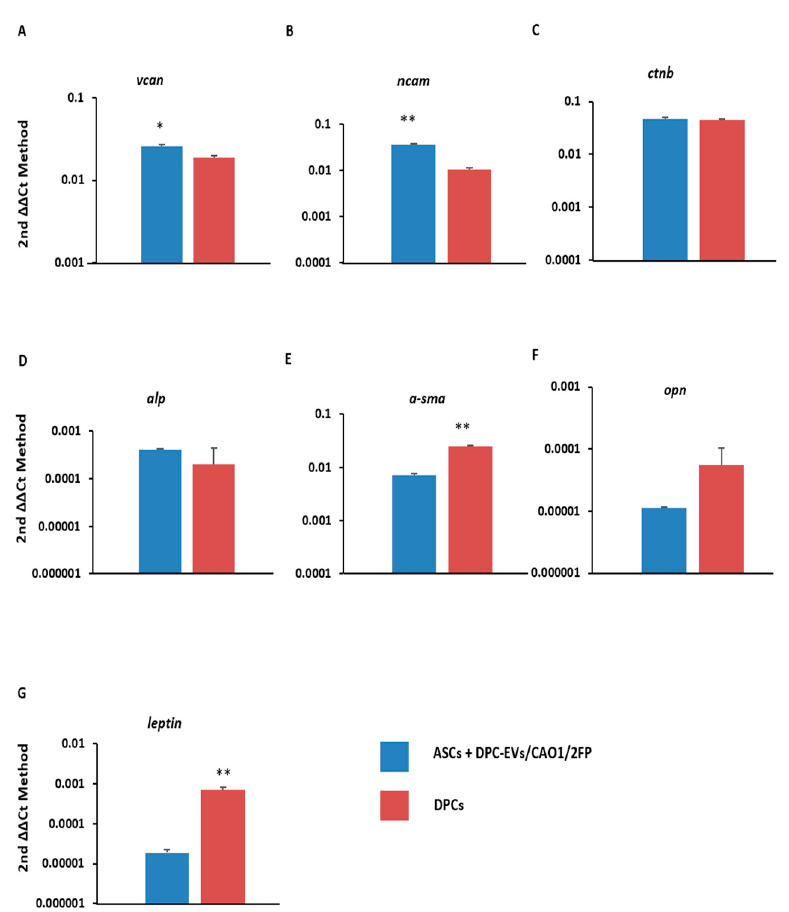
Figure 3. Comparison of hair induction related genes. ( A – G ) The gene expression was analyzed with real-time PCR, comparisons are illustrated between adipose-derived stem cells (ASCs) with DPC-EVs and dermal papilla cells (DPCs). Total RNA was isolated from each spheroid. The average gene expression for each category was obtained from three independent experiments measured in triplicate, and data are presented as the mean value ± SD (Error bars). * p < 0.05 and ** p < 0.01.